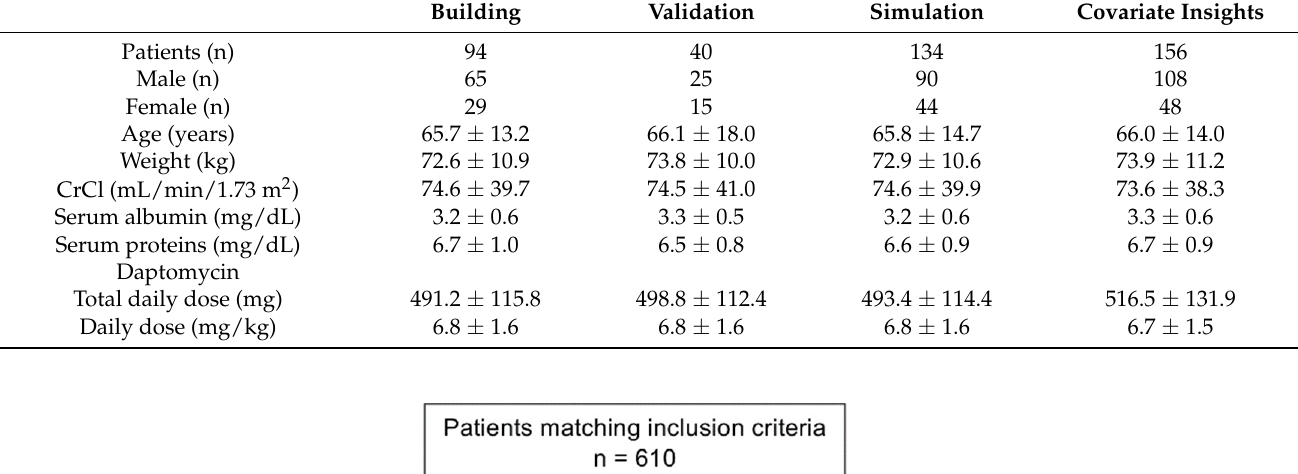
Table 1. Synthesis of patients’ data included in the present study, grouped by cohort.